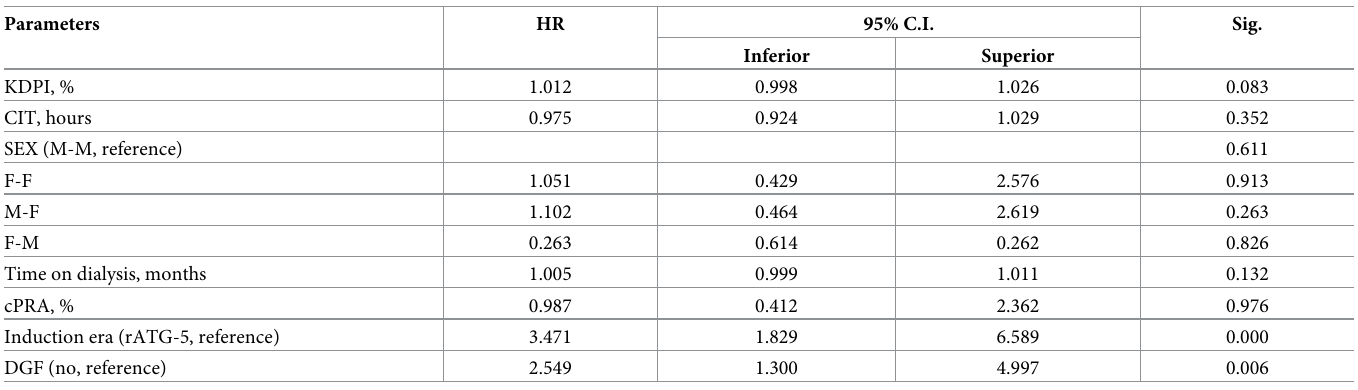
Table 6. Multivariable logistic regression analysis for 1 month eGFR < 48 ml/min/1.73 m 2 (n = 210). Parameters HR 95% C.I.